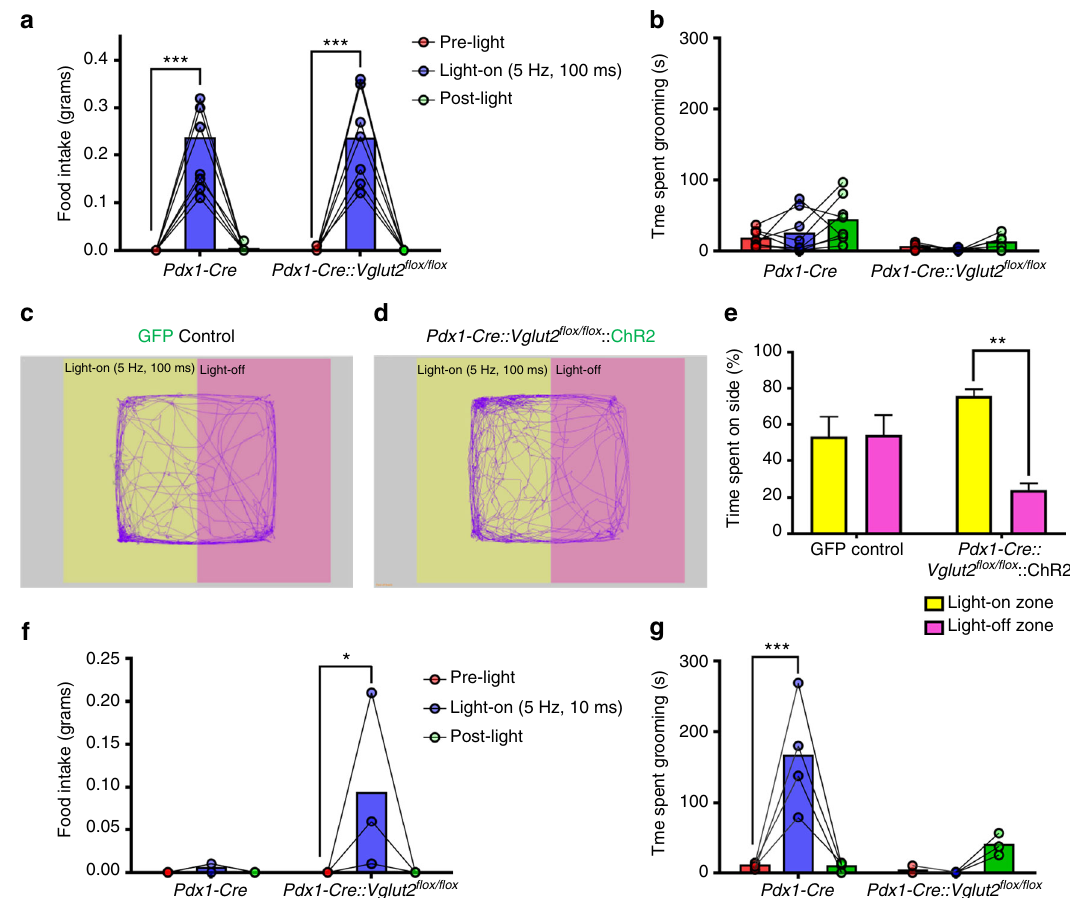
Fig. 3 LH Pdx1 → PVH evoked grooming requires glutamate release, and activation of non-glutamatergic fi bers promotes behavioral approach. Food intake ( a ) and grooming time ( b ) before (pre-light), during (light-on), and after (post-light) 5 Hz, 100 ms photostimulation of LH Pdx1-ChR2 → PVH fi bers in Pdx1-Cre ( n = 8) and Pdx1-Cre::Vglut2 fl ox/ fl ox ( n = 7) mice. Real-time place preference assay (RTPP) during optical stimulation of LH Pdx1 → PVH in GFP control ( n = 6) and Pdx1-Cre::Vglut2 fl ox/ fl ox ::ChR2 mice ( n = 4). c , d Representative tracks tracing locomotion; e Percentage time spent on each side. e Two-way ANOVA followed by Sidak ’ s multiple comparisons test (interaction F [1, 16] = 7.192, P = 0.0164; viral injection F [1, 16] = 0.1407, P = 0.7125; light zone F [1, 16] = 6.612, P = 0.0205. Pdx1-Cre::Vglut2 fl ox/ fl ox ::ChR2 (Light-off zone vs. Light-on zone) ** p < 0.005. Data presented as mean ± s.e.m. Food intake (f) and grooming time (g) before, during, and after 5 Hz, 10 ms photostimulation of LH Pdx1-ChR2 → PVH fi bers in Pdx1-Cre ( n = 4) and Pdx1-Cre::Vglut2 fl ox/ fl ox ( n = 3) mice. a , b, f and g Two-way repeated measures ANOVA followed by Dunnett ’ s multiple comparisons test. ( a interaction F [2, 26] = 0.003466, P = 0.9965; genotype F [1, 13] = 0.000817, P = 0.9776; light F [2, 26] = 66.15, P < 0.0001, subjects (matching) F [13, 26] = 0.9467, P = 0.5233. Pdx1-Cre and Pdx1-Cre:: Vglut2 fl ox/ fl ox [pre-light vs. light-on] *** p < 0.0005. b interaction F [2, 26] = 1.065, P = 0.3593; genotype F [1, 13] = 10.98, P = 0.0056; light F [2, 26] = 3.622, P = 0.0409; subjects (matching) F [13, 26] = 1.472, P = 0.1942. f interaction F [2, 10] = 3.073, P = 0.0912; genotype F [1, 5] = 3.073, P = 0.1400; light F [2, 10] = 3.808, P = 0.0590; subjects (matching) F [5, 10] = 1, P = 0.4651. Pdx1-Cre::Vglut2 fl ox/ fl ox (pre-light vs. light-on) * p < 0.05. g interaction F [2, 10] = 14.45, P = 0.0011; genotype F [1, 5] = 8.36, P = 0.0341; light F [2, 10] = 8.57, P = 0.0068; subjects [matching] F [5, 10] = 1.078, P = 0.4280. Pdx1-Cre (pre-light vs. light-on) *** p <